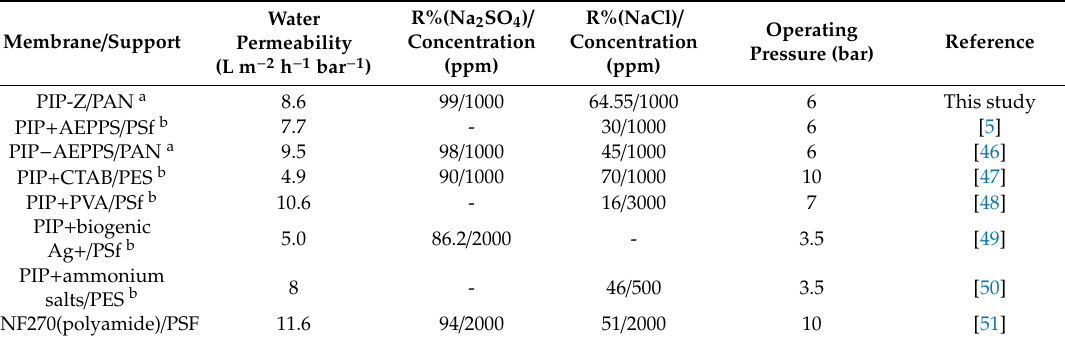
Figure 6. Water flux data and salt rejection as obtained for the different nanofiltration membranes. The operation pressure was fixed at 6 bar, and concentration of salt solution was 1000 ppm. Table 4. Comparison the other literature reported 349 PIP–TMC based NF membrane.